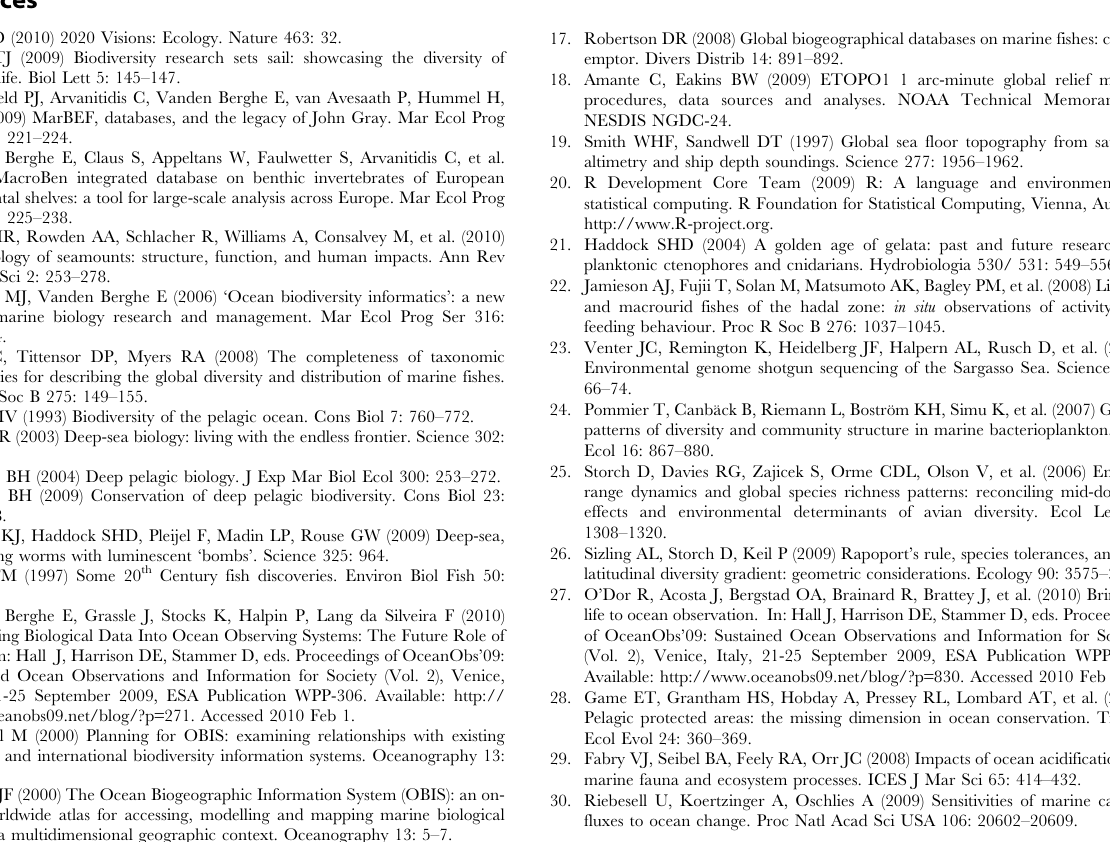
Figure S1 Global distribution of recorded marine biodiversity expressed as the proportion of OBIS records occurring at each position in the water column over each bottom depth. Only those cells (unique combinations of sample and bottom depth, following the scheme in Table 1) contributing more than 1% of records from a given bottom depth are coloured. To provide an alternative scale to Figure 2, where the size of each cell represents the volume of water it contains, here we transform both the vertical depth axis (d) and the horizontal area axis (a) (d 9 = d 2/3 , a 9 = ! a). This better shows the relatively high number of records in surface waters, as well as patterns in the smaller depth zones (e.g., continental shelf, hadal